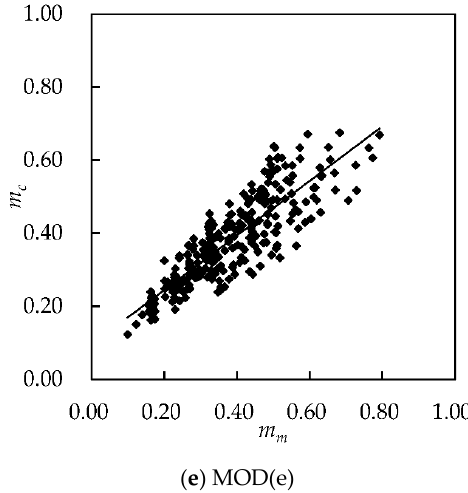
Figure 8. The comparisons between m c and m m .